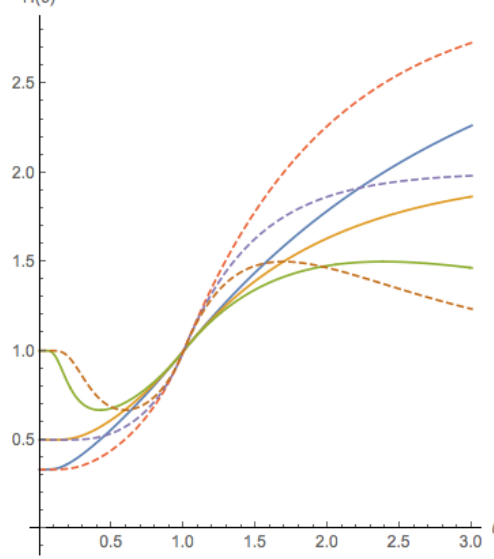
Figure 4. Members from the ESHE family of functions. The solid lines are for η = 1/2 ( H (cid:48) ( 1 ) = 1) and the dotted lines are for η = 1 ( H (cid:48) ( 1 ) = 2). For each η , functions are plotted for ρ = 1,0, − 1. When ρ < 0, the function is non-monotonic, as defined in the main